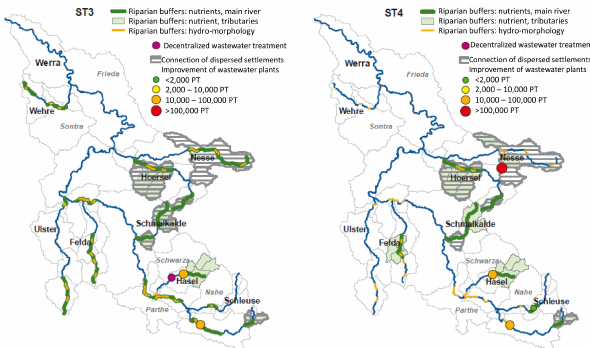
Figure 4. Priority areas for actions within the two strategies fo- cussing on polluter pays principle (ST3, left) and cost-efficiency (ST4, right). PT is the total sewage plant capacity of population equivalent (changed from Dietrich and Schumann, 2006, ST1 and ST2 are shown in Dietrich and Funke,